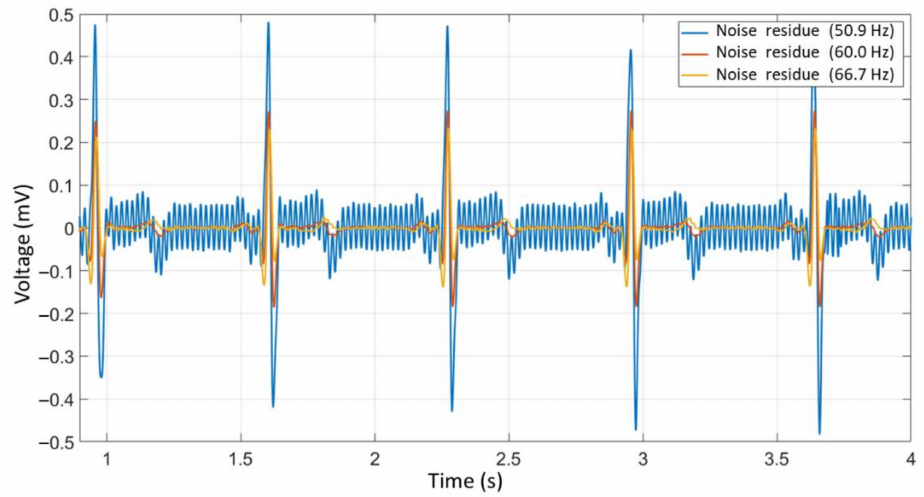
Figure 18. Noise residue after filtering (60 Hz, maximum SNR, and minimum